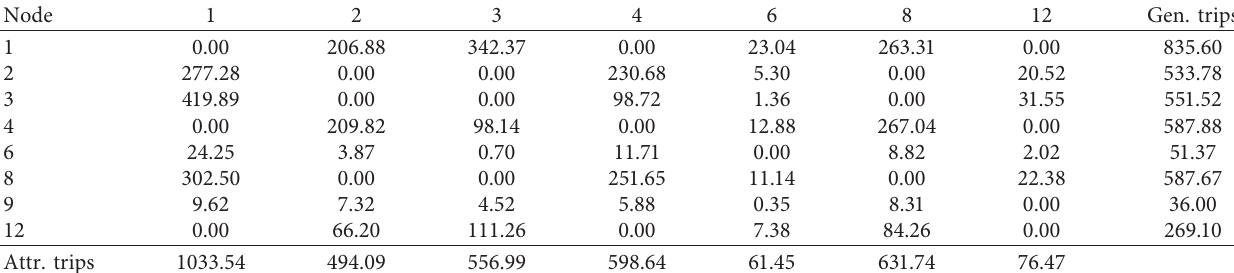
Table 7: OD matrix resulting after the application of Step 1 according to F